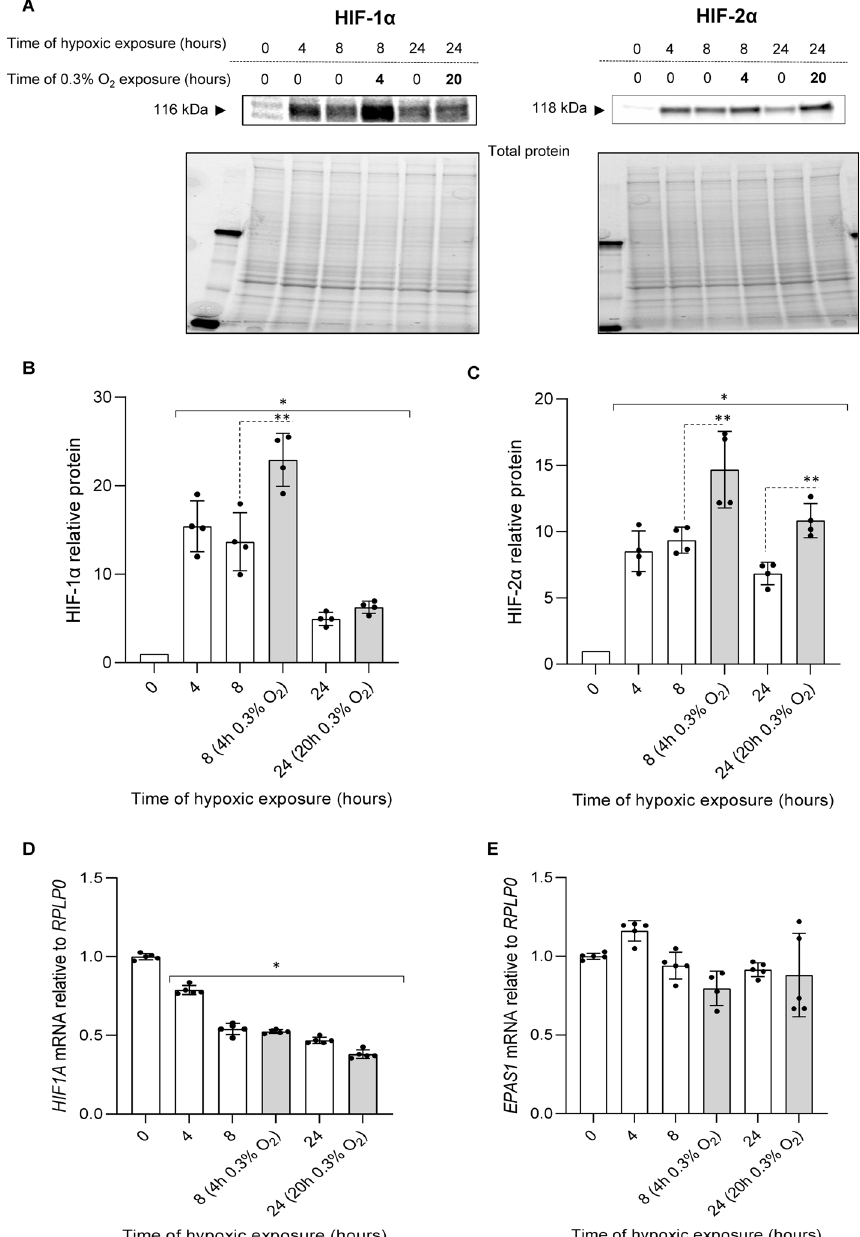
Fig. 6 Inhibition of PHD activity during hypoxia by reducing oxygen levels results in accumulation of HIF-1α and HIF-2α in HUVECs. Cells were exposed to 1% O 2 for 4 h, and next moved to 0.3% O 2 (grey bars) or remained in the same conditions for the time periods specified, and total RNA and protein lysates were collected. The changes in HIF-1α and HIF-2α protein levels were evaluated by western blot ( A ) normalized to total protein levels and related to the normoxic control ( B , C ). Data represent the mean SD of four ± independent experiments. * P < 0.05 was considered significant. HIF1A and EPAS1 mRNA levels were quantified by qRT-PCR and normalized to RPLP0 mRNA levels and expressed as a fold change over normoxic samples ( D , E ). Data represent the mean SD of five independent experiments (3 replicates each). * P < 0.05 ± was considered